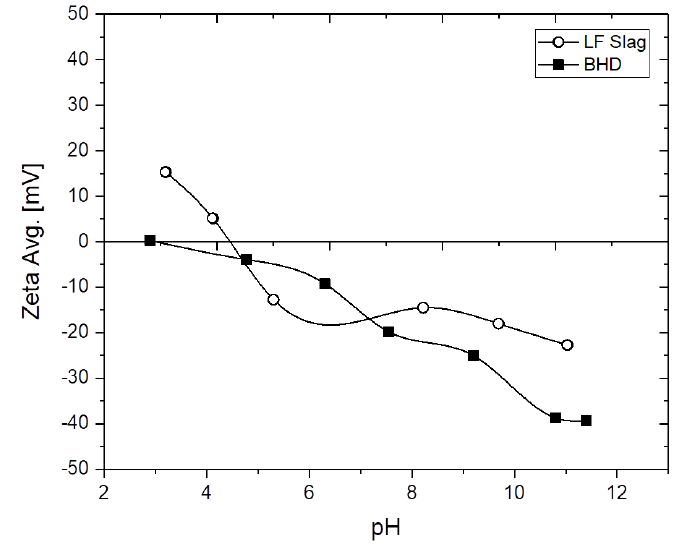
Figure 2. Zeta potential of steel dust LF and BHD in distilled water.